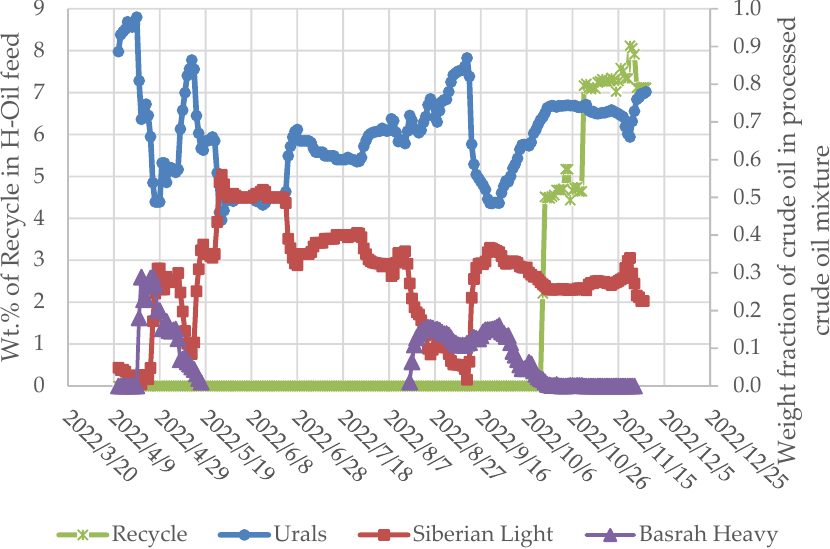
Figure 5. Variation of the individual crude oil share in the crude oil mixture processed during the studied period, and the recycle share in the hydrocracker feedstock.